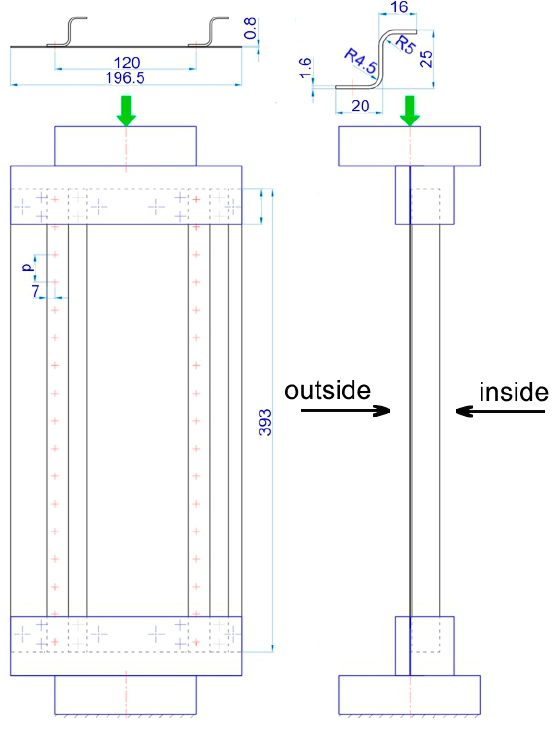
Figure 1. Dimensions of the panel and boundary conditions in the compression test.